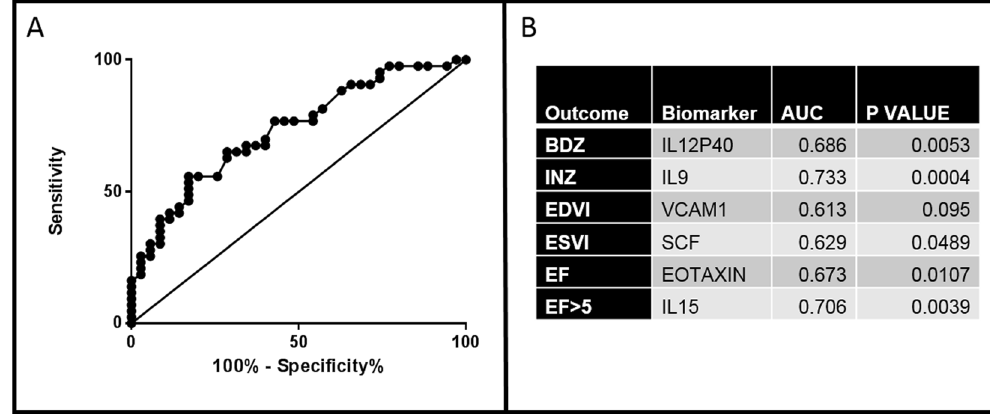
Figure 2. ( A) . Representative ROC for IL9 with the Δ INZ metric gives an AUC of 0.73 (P < 0.001). Biomarkers with the highest AUC value for each type of outcome metric are shown in panel B.